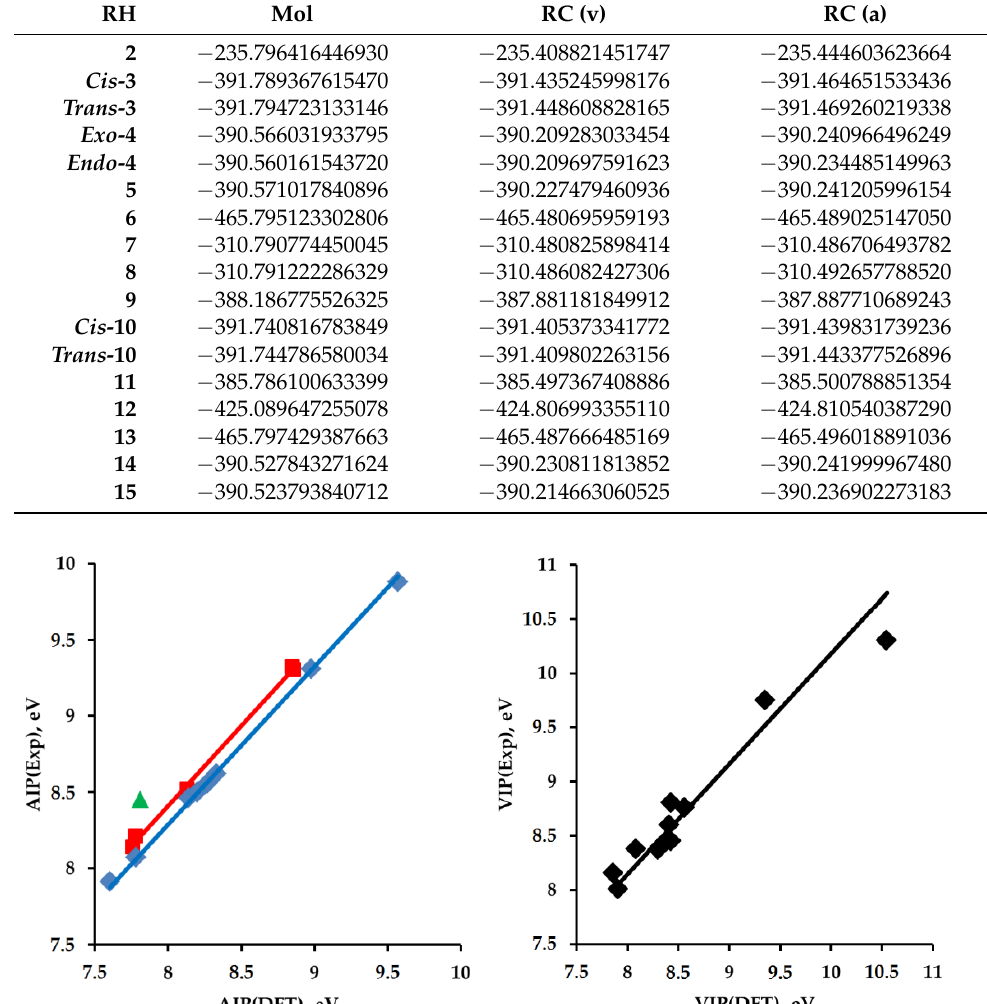
Figure 4. Correlations between DFT calculated and experimental values of AIP ( left ) and VIP ( right ): AIP(Exp) = 1.0363AIP(DFT), R 2 = 0.9988 (blue); AIP(Exp) = 1.051AIP(DFT), R 2 = 0.9982 (red); VIP(Exp) = 1.0178VIP(DFT), R 2 = 0.9223 (black).